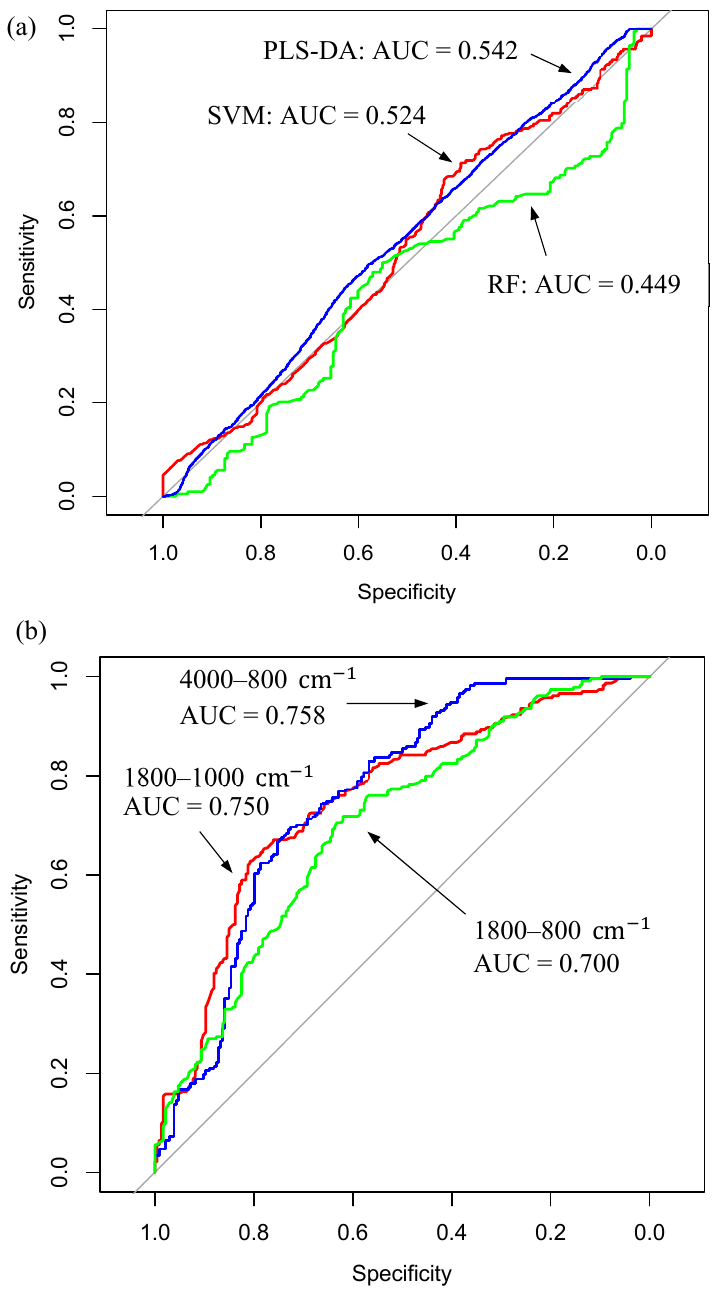
Figure 10. Single model receiver operator characteristic (ROC) graphs for the ( a ) whole serum dataset displaying the PLS-DA (blue), SVM (red) and RF (green) classifiers; and ( b ) the best performing model for each of the tested filtrate fractions: the full spectrum (4000–800 cm − 1 , blue), the fingerprint region (1800–1000 cm − 1 , red) and the extended fingerprint region (1800–800 cm − 1 , green). The < 3 kDa filtered serum ‘full spectra’ dataset (4000–800 cm ) delivered the greatest